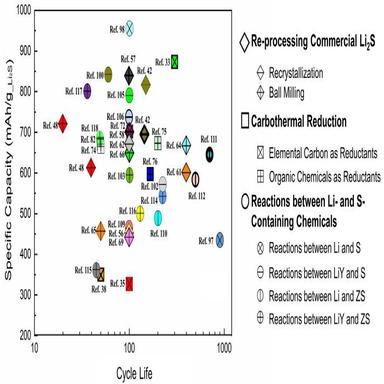
The comparison of cycling performance among various Li2S-NCs synthesized via different methods. The frame thickness of the symbol represents the charging rate, where the thicker the frame, the greater the rate. Dissimilar symbol colors represent different articles.